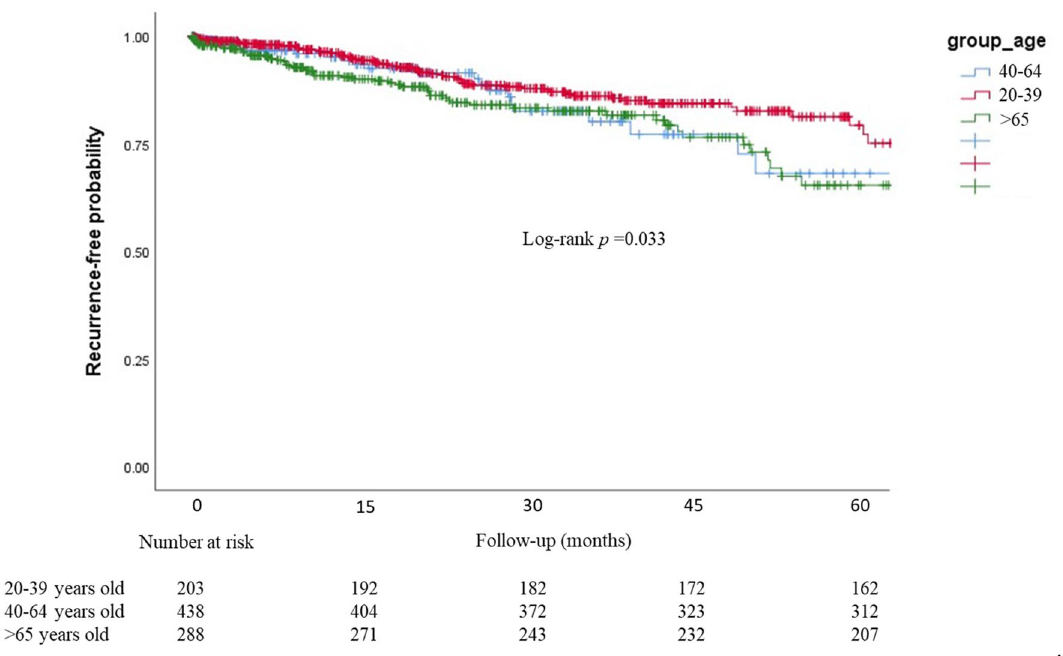
Figure 2. The Kaplan–Meier plot for recurrence free probability stratified by age groups during